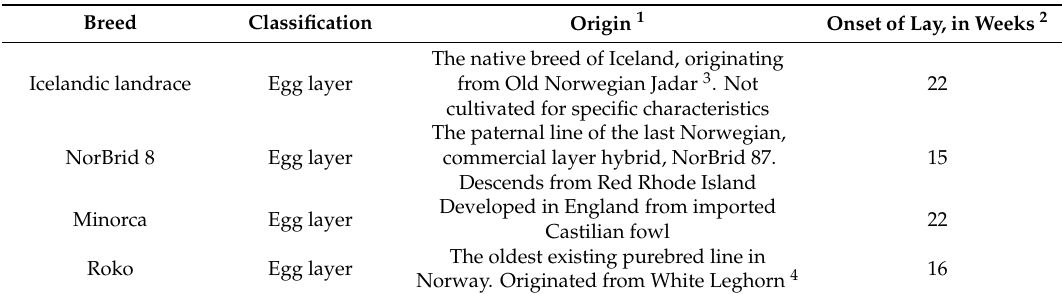
Table 1. Laying hen breeds and characteristics.